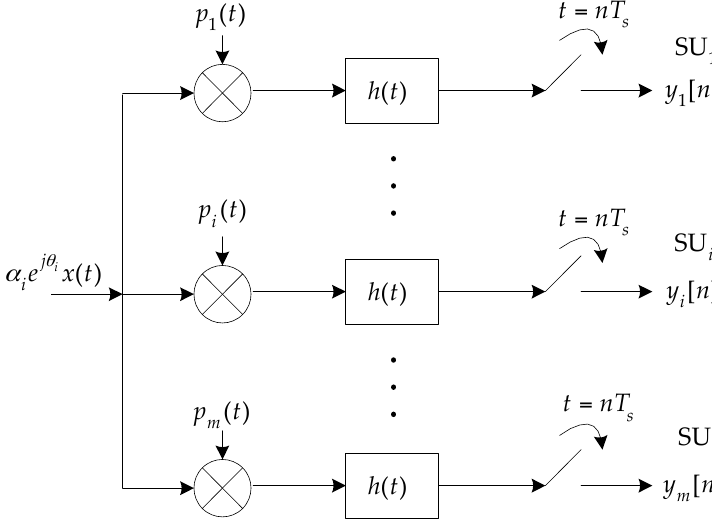
Figure 3. Practical DMWC sampling model.